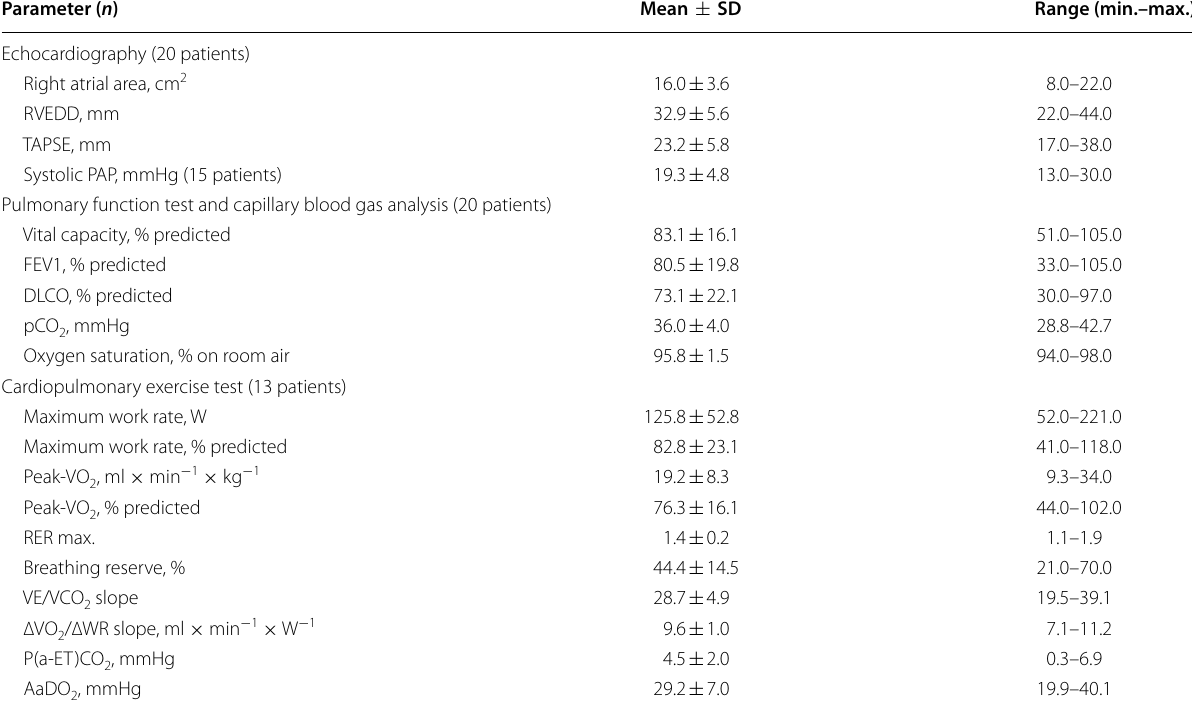
AaDO 2 alveolar–arterial difference in partial pressures of oxygen; DLCO diffusion capacity of the lung for carbon monoxide; FEV1 forced end-expiratory volume in one second; PAP pulmonary arterial pressure; P(a-ET)CO 2 arterial to end-tidal difference in partial pressures of CO 2 ; RER respiratory exchange rate; RVEDD right ventricular end-diastolic diameter; TAPSE tricuspid anterior plane systolic excursion